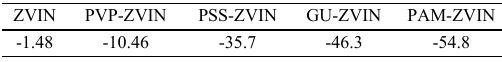
Table 3. The zeta potential values(mV) of bare and polymer stabilized-ZVINs